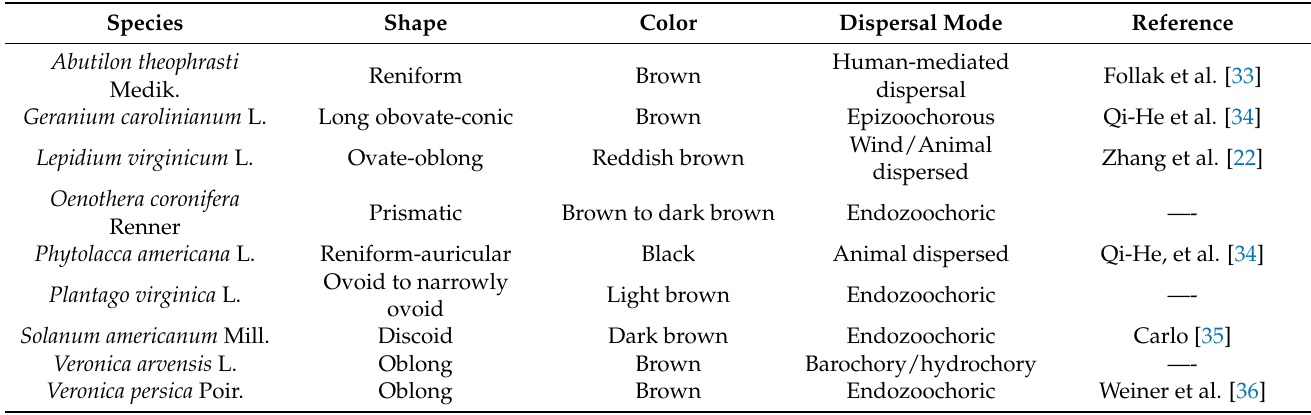
Table 1. Seed morphology and dispersal mode of the nine invasive species. Traces indicate the absence of relevant literature about dispersal mode. For more details of the study species, such as family, collection date and site, habit, habitat, invasion level and origin, please check Table S1 (Supplementary